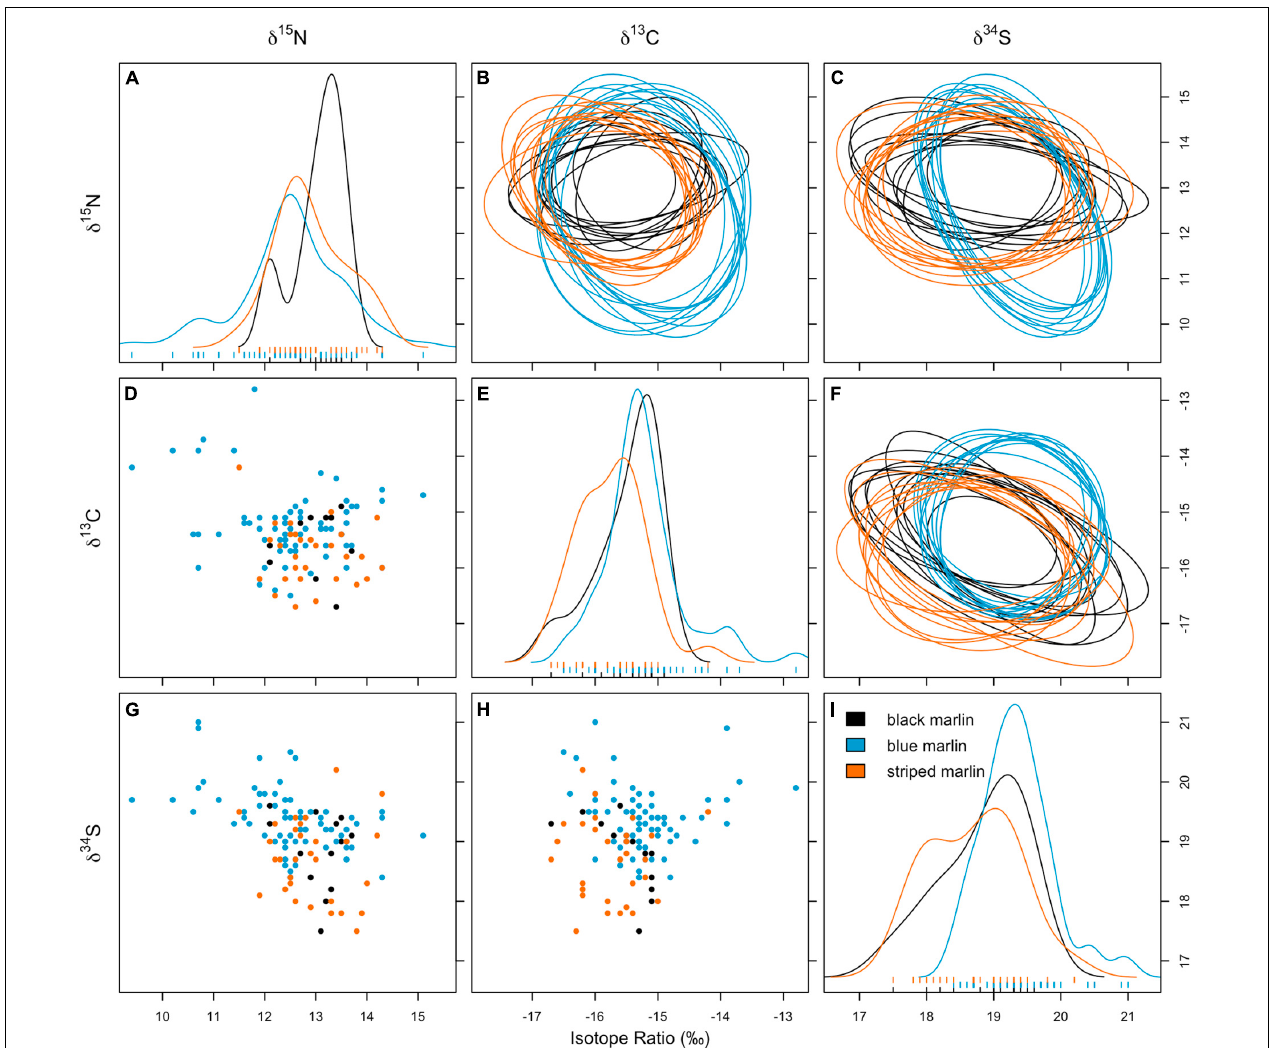
FIGURE 2 | Biplots for δ 13 C vs. δ 15 N (D) , δ 15 N vs. δ 34 S (G) , and δ 13 C vs. δ 34 S (H) ; density plots showing distribution of isotope values of δ 15 N (A) , δ 13 C (E) , and δ 34 S (I) ; and bayesian ellipse areas (10 runs plotted) using posterior estimates of ellipses for δ 13 C vs. δ 15 N (B) , δ 15 N vs. δ 34 S (C) , and δ 13 C vs. δ 34 S (F) for three marlin species: black marlin ( Istiompax indica ), blue marlin ( Makaira nigricans ), and striped marlin ( Kajikia audax